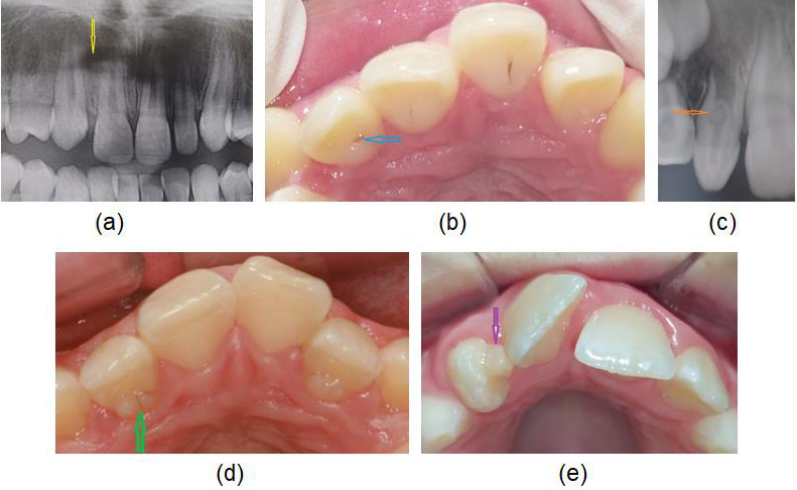
Figure 2. Different dental anomalies: ( a ) hypodontia, ( b ) palatal pit, ( c ) dens invaginatus, ( d ) palato- cervical groove and ( e ) talon cusp.